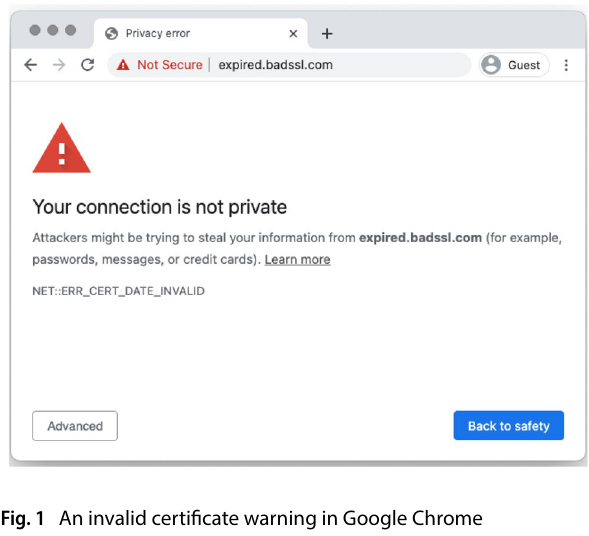
Fig. 1 An invalid certificate warning in Google Chrome